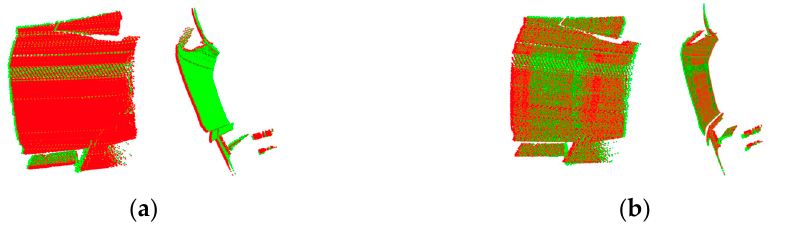
Figure 22. Comparison of the effect of one stitching at the same position. ( a ) Initial point cloud stitching. ( b ) DeepMerge algorithm correction.